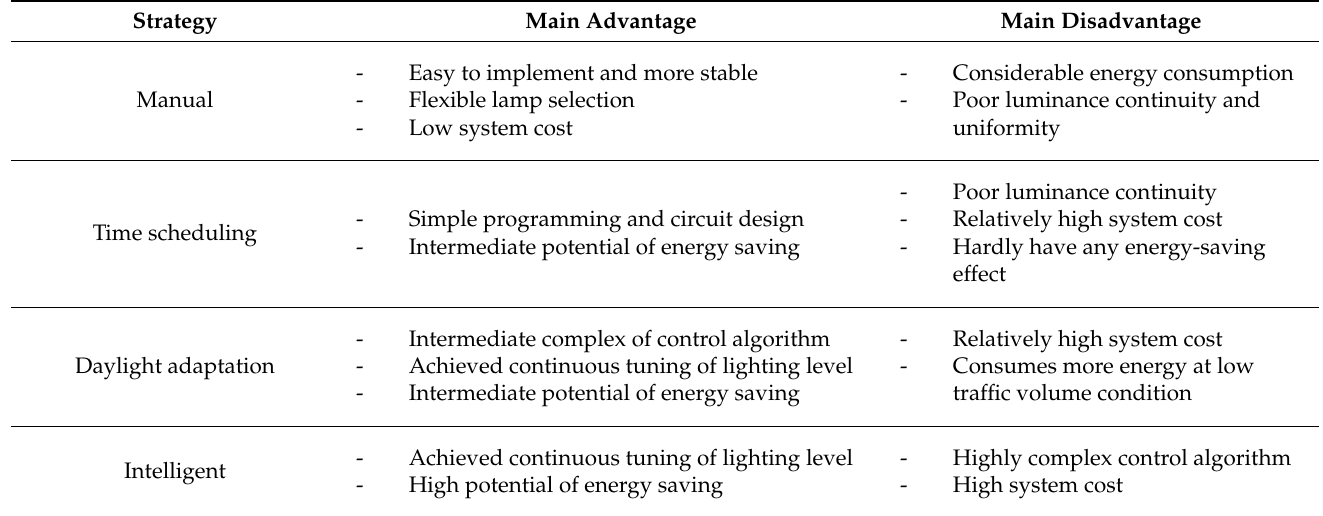
Table 3. Lighting control strategies ’ analysis.